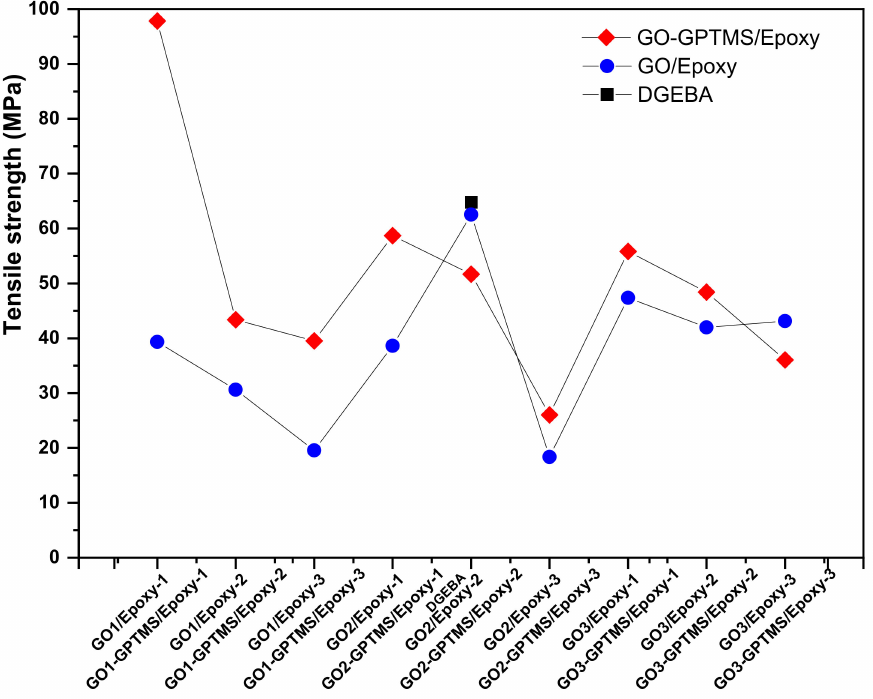
Figure 14. Resistance to traction of DGEBA, GO/epoxy, and GO-GPTMS/epoxy nanocomposites. Table 5. Mechanical properties of pure epoxy and compound materials GO/epoxy and GO- GPTMS/epoxy between 1 and 3% weight